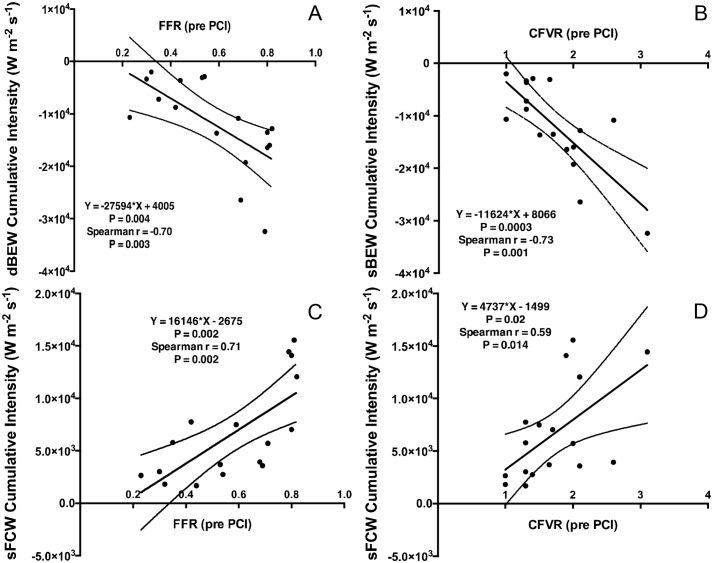
Relationship of Pre-PCI FFR / CFVR with Accelerative Wave intensity.
(A) Fractional Flow Reserve and cumulative intensity of the dBEW, (B) Coronary Flow Velocity Reserve and cumulative intensity of the dBEW, (C) Fractional Flow Reserve and cumulative intensity of sFCW. (D) Coronary Flow Velocity Reserve and cumulative intensity of the sFCW. Equations for the regression lines and 95% confidence intervals are shown. All measurements were taken distal to the stenosis, prior to PCI, during adenosine-induced hyperemia. FFR, Fractional Flow reserve; CFVR, Coronary Flow Velocity Reserve; sFCW, systolic Forward travelling Compression Wave; dBEW, diastolic Backward travelling Expansion Wave.